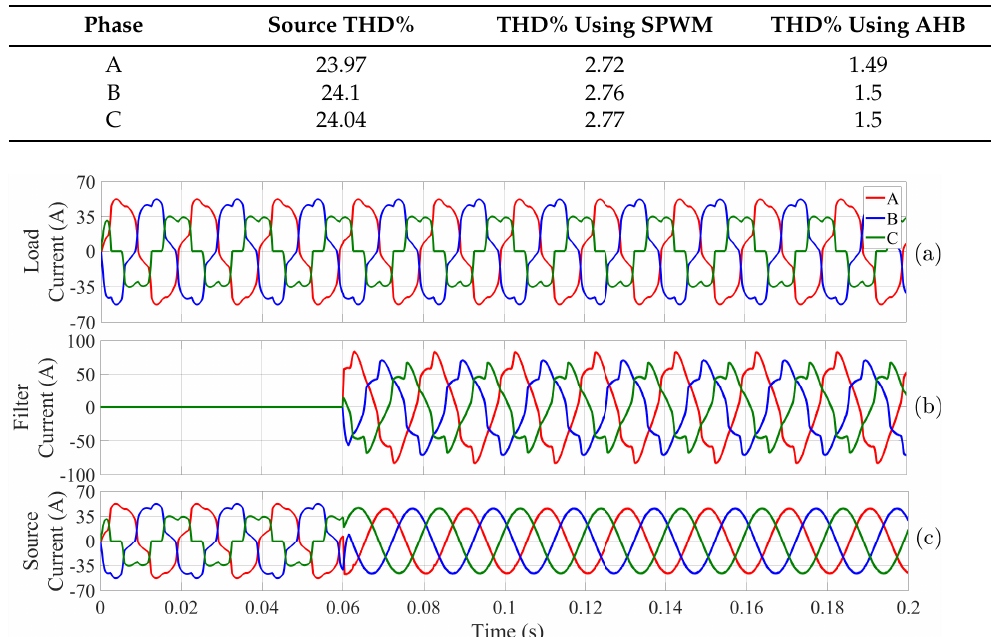
Figure 11. The simulation results of the current waveform before and after compensation the harmonics: ( a ) load current, ( b ) filter current, and ( c ) source current. Table 6. The current THD for the case of current harmonics.